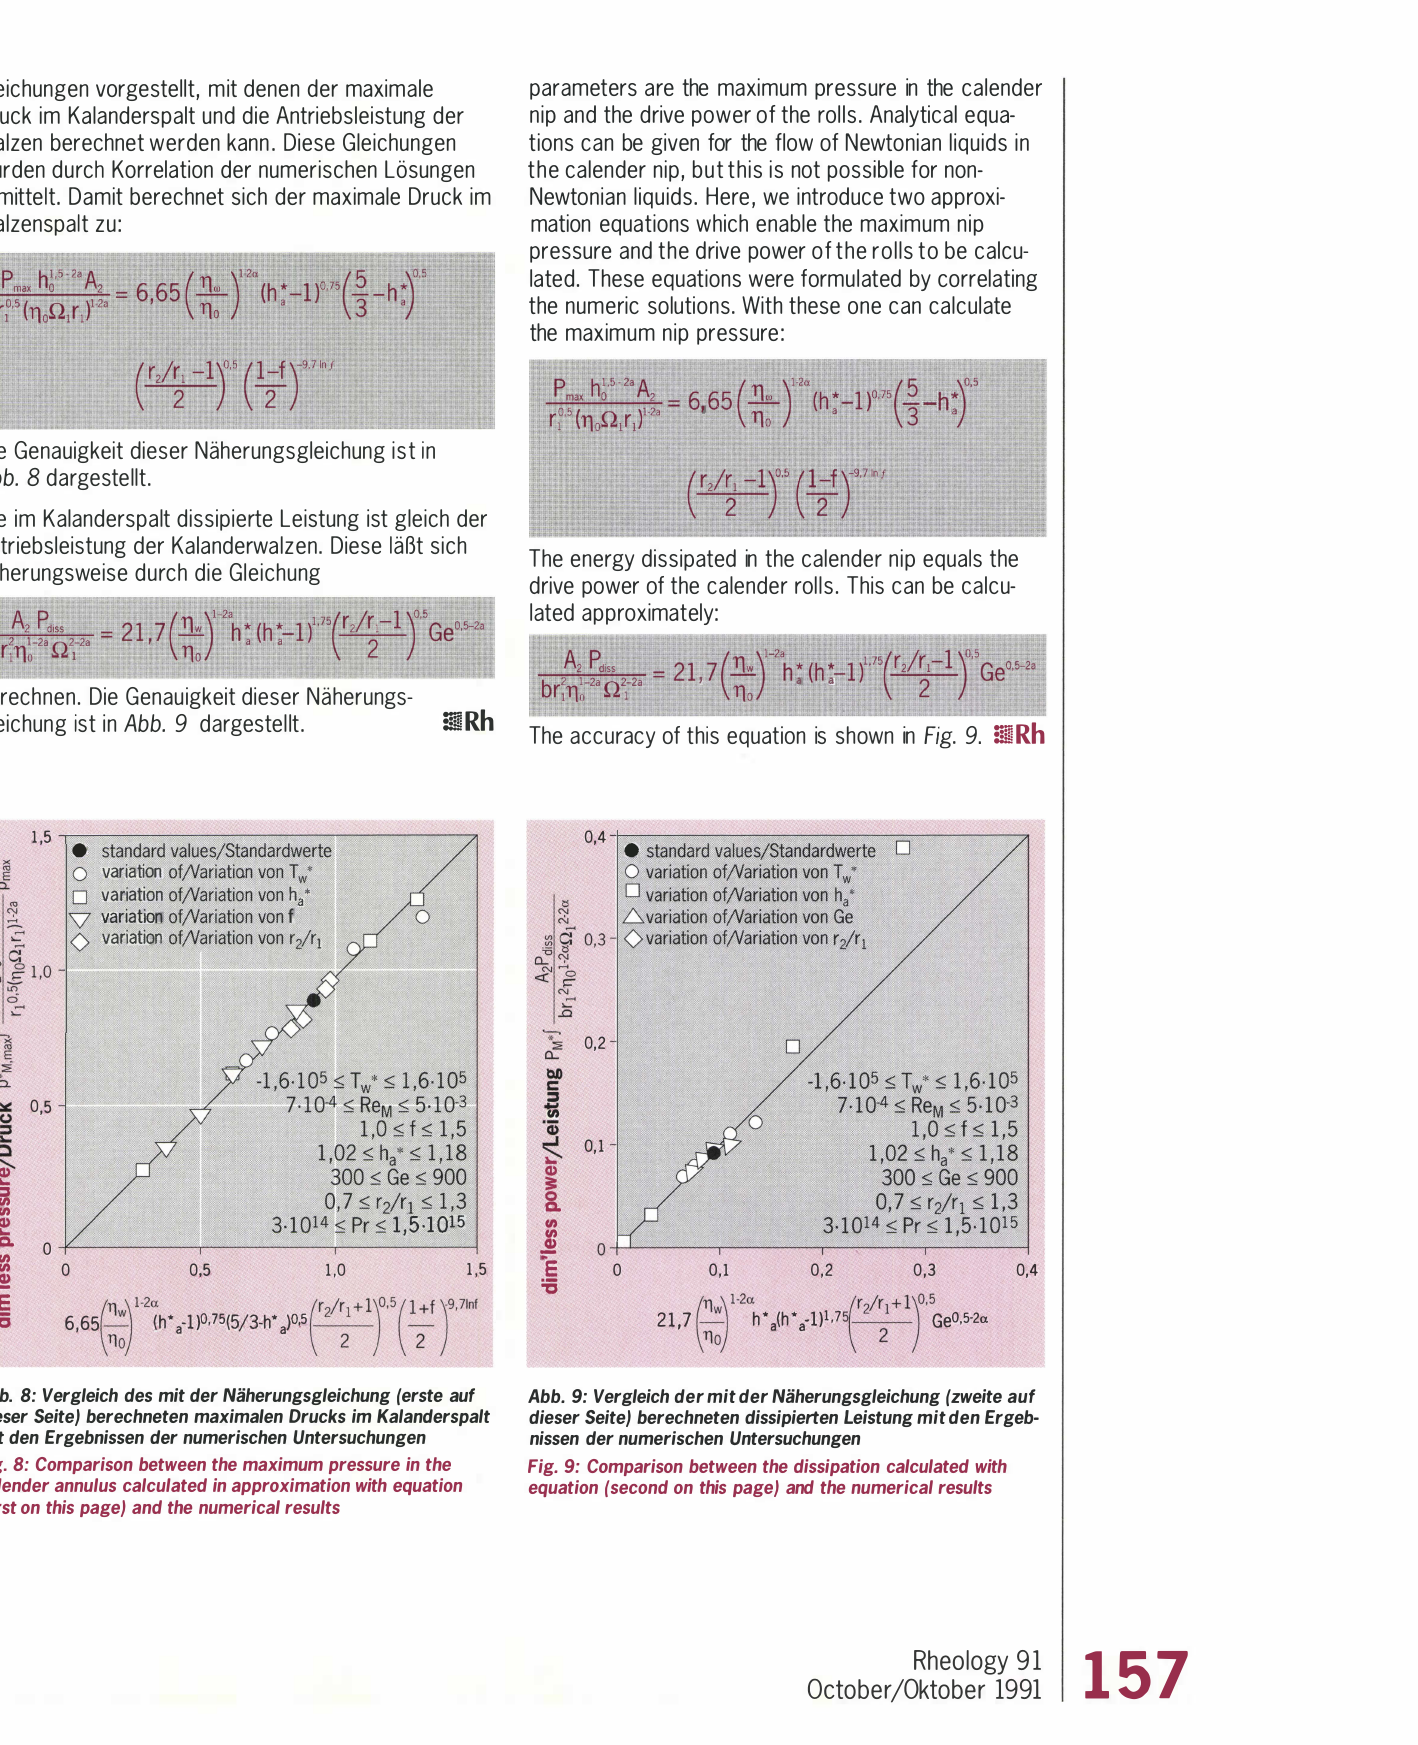
Fig. 9: Comparison between the dissipation calculated with equation (second on this page) and the numerical